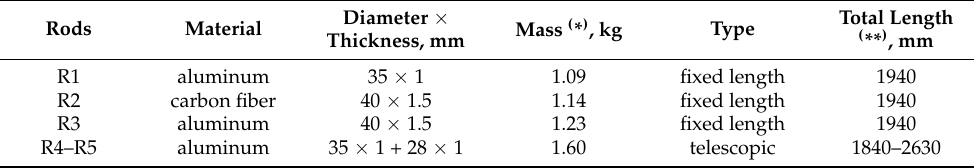
(*) Handle and electric cable inside the rod included; (**) Rod + Handle + Rear